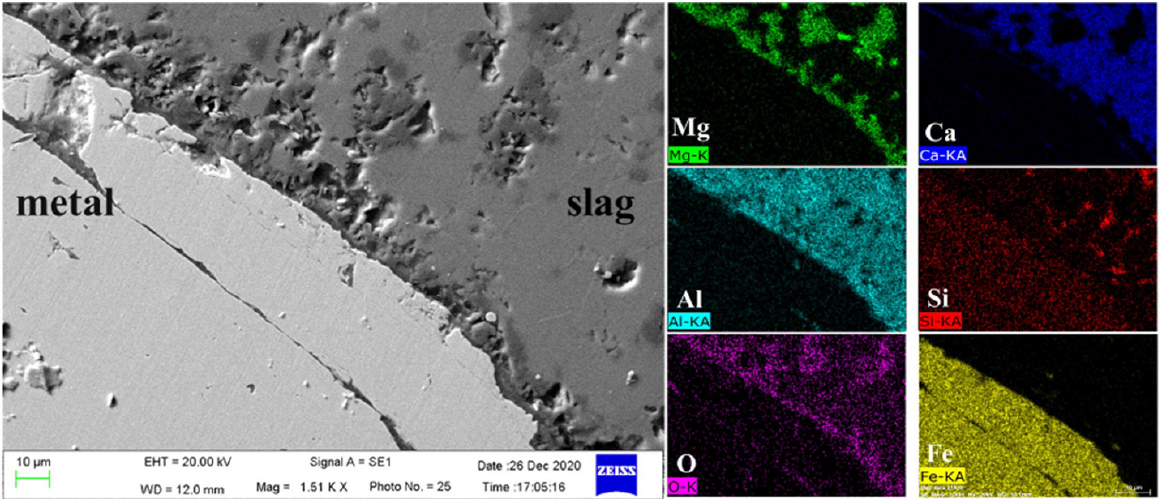
Figure 8. Micro-morphology and element mapping of quenched sample (Fe-5Al Alloy and low SiO 2 flux) after reacting at 1873 K for 7 min.